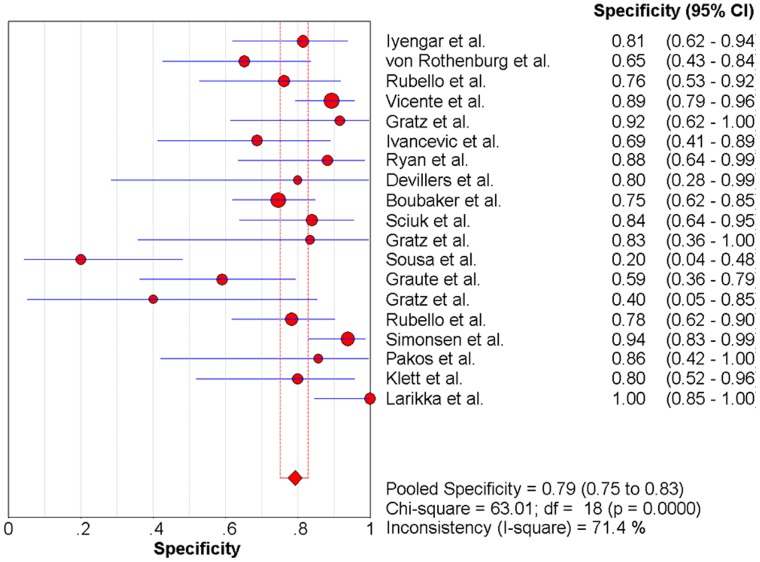
Forest plot for the specificity of anti-granulocyte scintigraphy with 99mTc-monoclonal antibodies to diagnose periprosthetic joint infections (PJI).Specificity  =  0.79 (95%CI, 0.75-0.83).